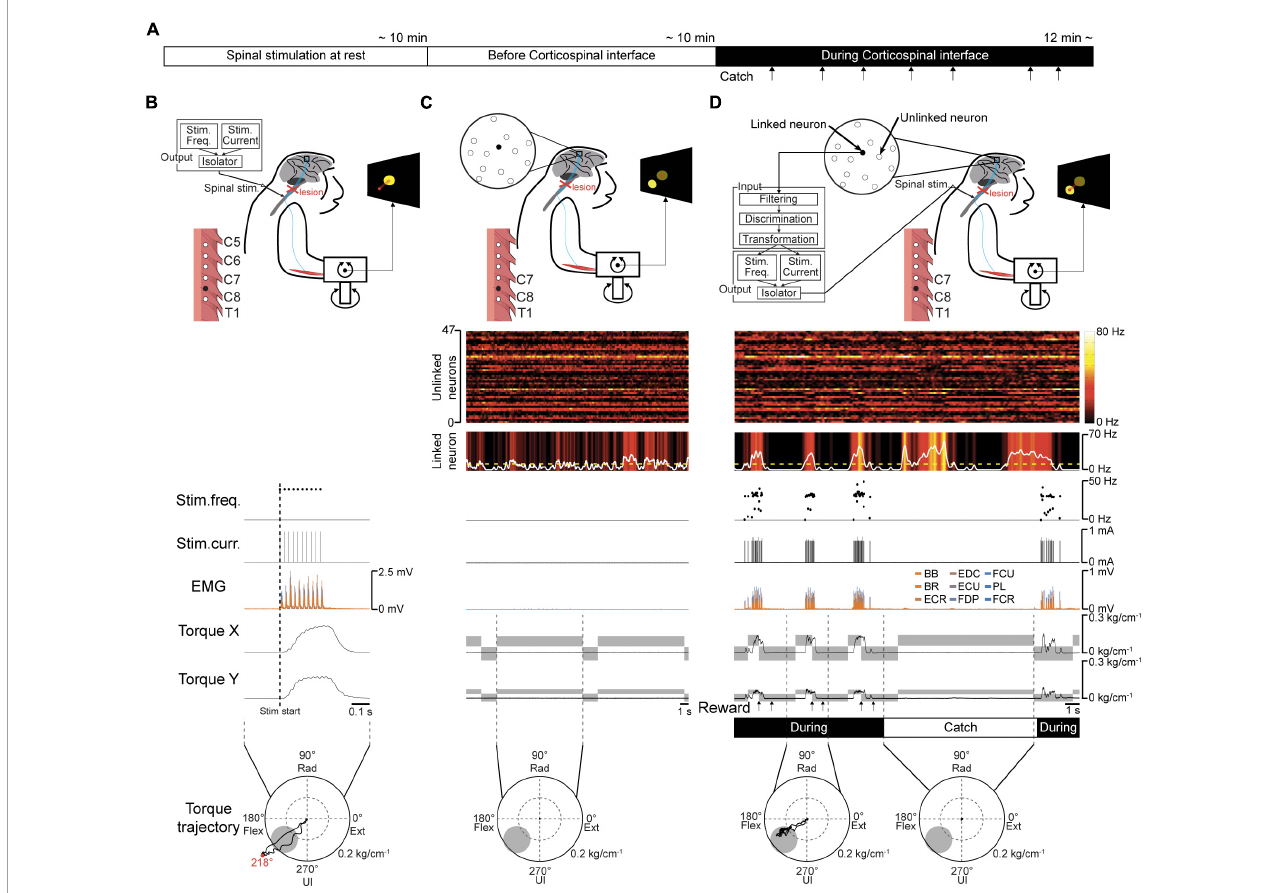
FIGURE3 Volitional control of a paralyzed forearm using the corticospinal interface. (A) Experimental procedure. First, an experiment of “Spinal stimulation at rest” was conducted to confirm the direction and magnitude of the evoked wrist torque induced by tonic spinal stimulation at rest. Next, the monkeys performed the torque-tracking task without the corticospinal interface as an experiment of “Before corticospinal interface”. Subsequently, a linked neuron was connected to the spinal site via the interface, which was called an experiment of “During corticospinal interface”. Catch trials (upward arrows) were interleaved at random intervals. (B) An example of an experiment of “Spinal stimulation at rest”. EMG and wrist torque were produced by stimulation of C8 at 1.8 mA and 40 Hz. The peripheral target position (gray circle in two-dimensional plot of wrist torque) was set in the same direction as the evoked torque and at a location at which half of the maximum magnitude of evoked torque was required. (C) An example of an experiment of “Before corticospinal interface”. The monkeys controlled the position of a cursor (red circle) using wrist torque to acquire targets (yellow circle) displayed on the screen. The activity of a single neuron (linked neuron, black) in the hand area of M1 was detected in order to utilize its neuronal activity as an input source for controlling the stimulation of a single spinal site (black) in the next experiment of “During corticospinal interface”. (D) An example of an experiment of “During corticospinal interface”, including three successful trials when the corticospinal interface was on (During, 8th row) and one catch trial when it was switched off (Catch, 8th row). The modulation of 48 neurons (1st and 2nd rows) was detected through the Utah array in M1 and the activity of a single neuron (linked neuron, 2nd row) was selected from them as the input signal for controlling stimulus frequency (3rd row) and intensity (4th row) via the corticospinal interface. Stimulation frequency and current were determined according to the firing rate of the linked neuron above a stimulation threshold (yellow dashed line in the 2nd row). The gray rectangles in the wrist torque traces (6th and 7th rows) represent the peripheral and center targets. The arrows at the bottom indicate successful trial completion and the delivery timing of the juice reward (7th